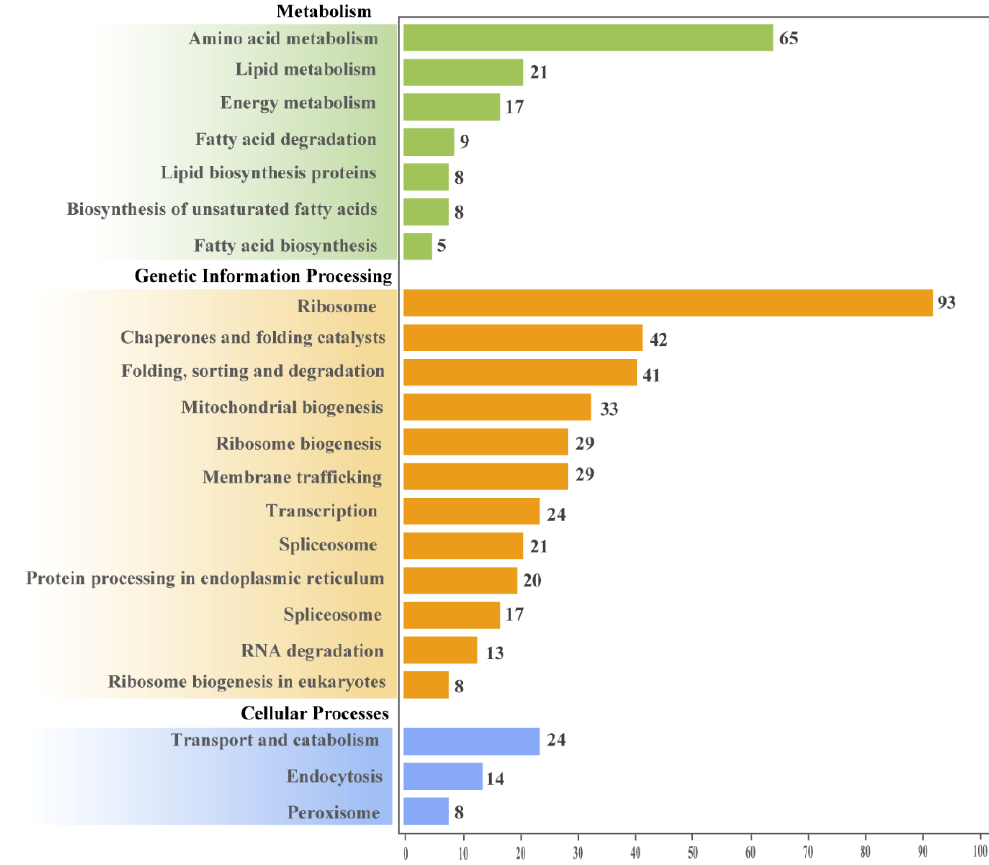
Figure 3. Number of DEGs annotated in different KEGG pathways.